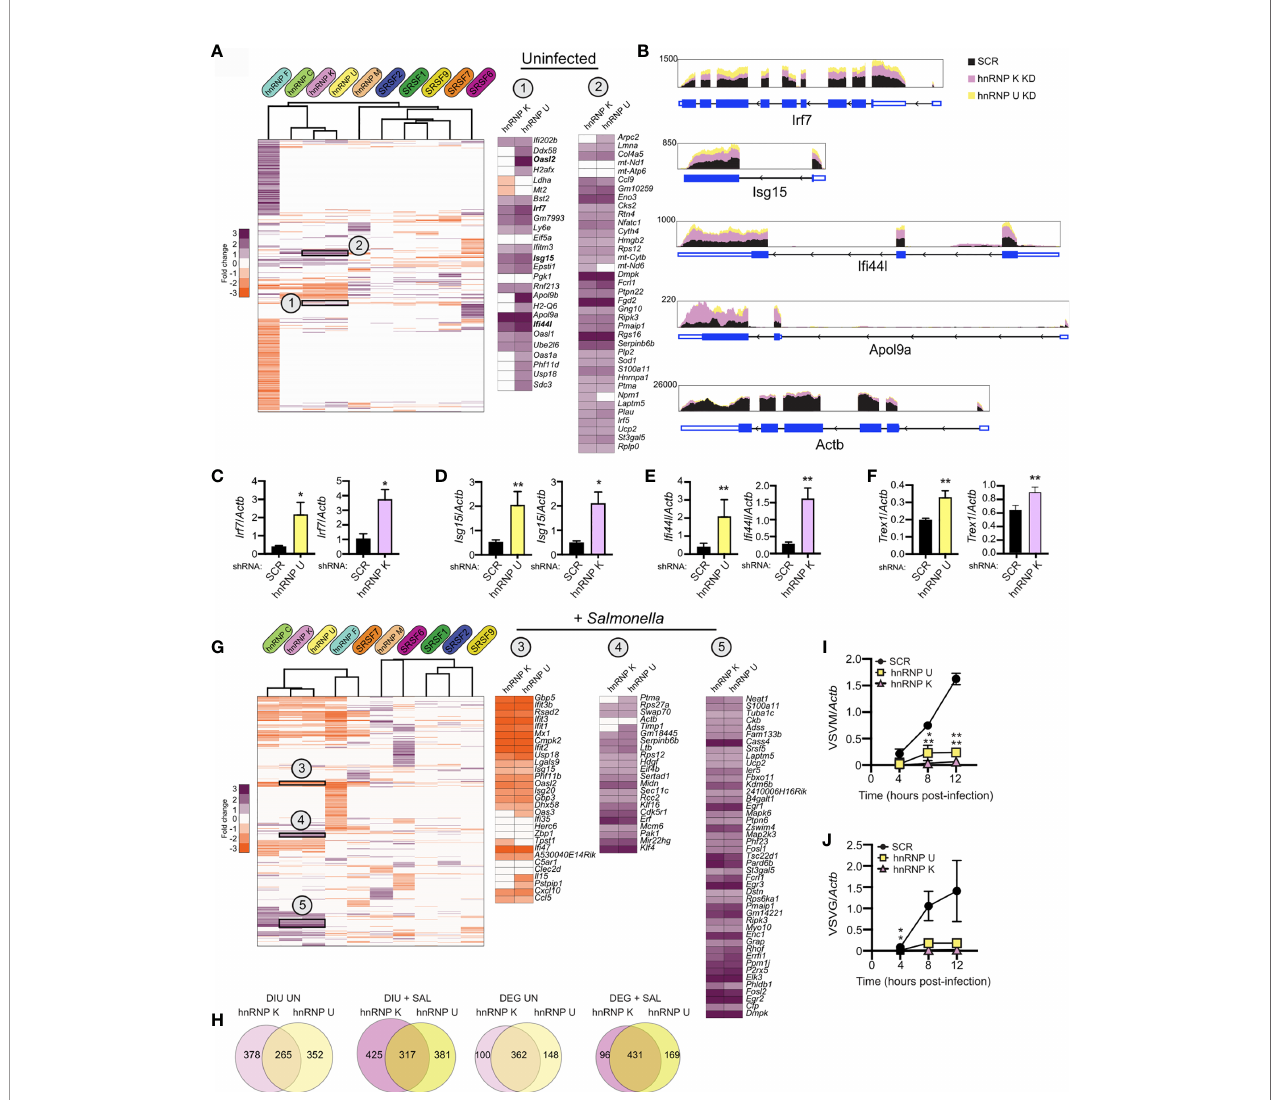
FIGURE 8 | Loss of hnRNP K and hnRNP U affects similar DEGs and DIU and impacts the ability of RAW 264.7 macrophages to control viral replication. (A) Hierarchical clustering of up- and down-regulated DEGs in uninfected macrophages (SR/hnRNP knockdown vs. SCR). Zoom-ins of clusters of interest (1 and 2) are shown to the right. Correlation of Cluster 1 is 0.84; Cluster 2 is 0.76. To allow for better visualization of DEGs, the scale is set at -3 to +3. (B) IGV tracks showing RNA-seq reads for Irf7 , Isg15, I fi 44l , and Apol9a in hnRNP K and hnRNP U compared to SCR control reads. Actb is included as a representative unaffected control gene. (C) RT-qPCR validation of Irf7 basal expression in hnRNP U and K knockdown cell lines vs. SCR controls. Data is displayed as Irf7/Actb . (D) As in (C) but for Isg15 . (E) as in (C) but for I fi 44l . (F) as in (C) but for Trex1 . (G) As in (A) but for Salmonella -infected macrophages. Correlation of Cluster 3 is 0.75; Cluster 4 is 0.78; Cluster 5 is 0.72. (H) Overlap of DIUs and DEGs in uninfected and Salmonella -infected hnRNP K and U knockdown macrophages. (I) Vesicular Stomatitis Virus (VSV) replication (as measured by RT-qPCR of the VSVM gene relative to Actb ) in hnRNP K and hnRNP U knockdown macrophages compared to SCR controls (VSV MOI = 1) at 4, 8, and 12h post-infection. (J) as in (I) but for VSVG. For all RT-qPCRs, values are the mean of 3 biological replicates and error bars indicate standard deviation. *p < 0.05; **p <